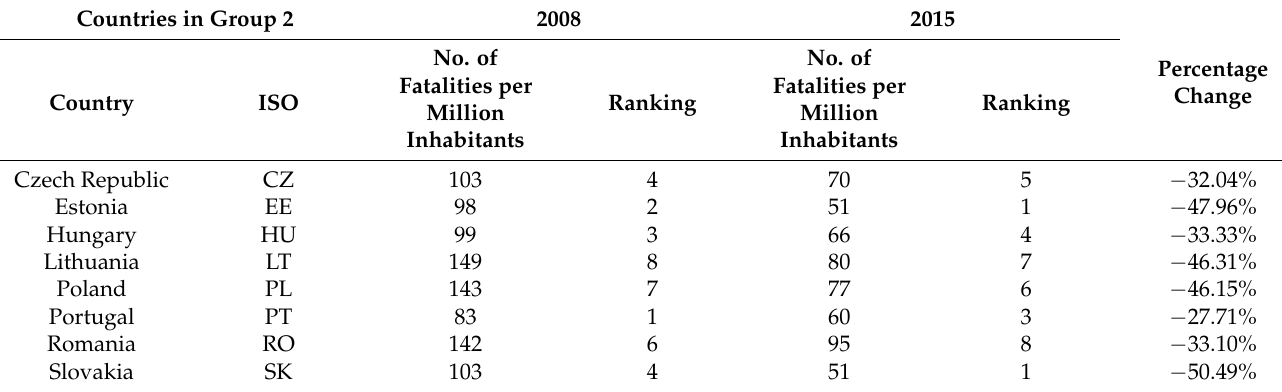
Table A4. The road fatality data for the countries in Group